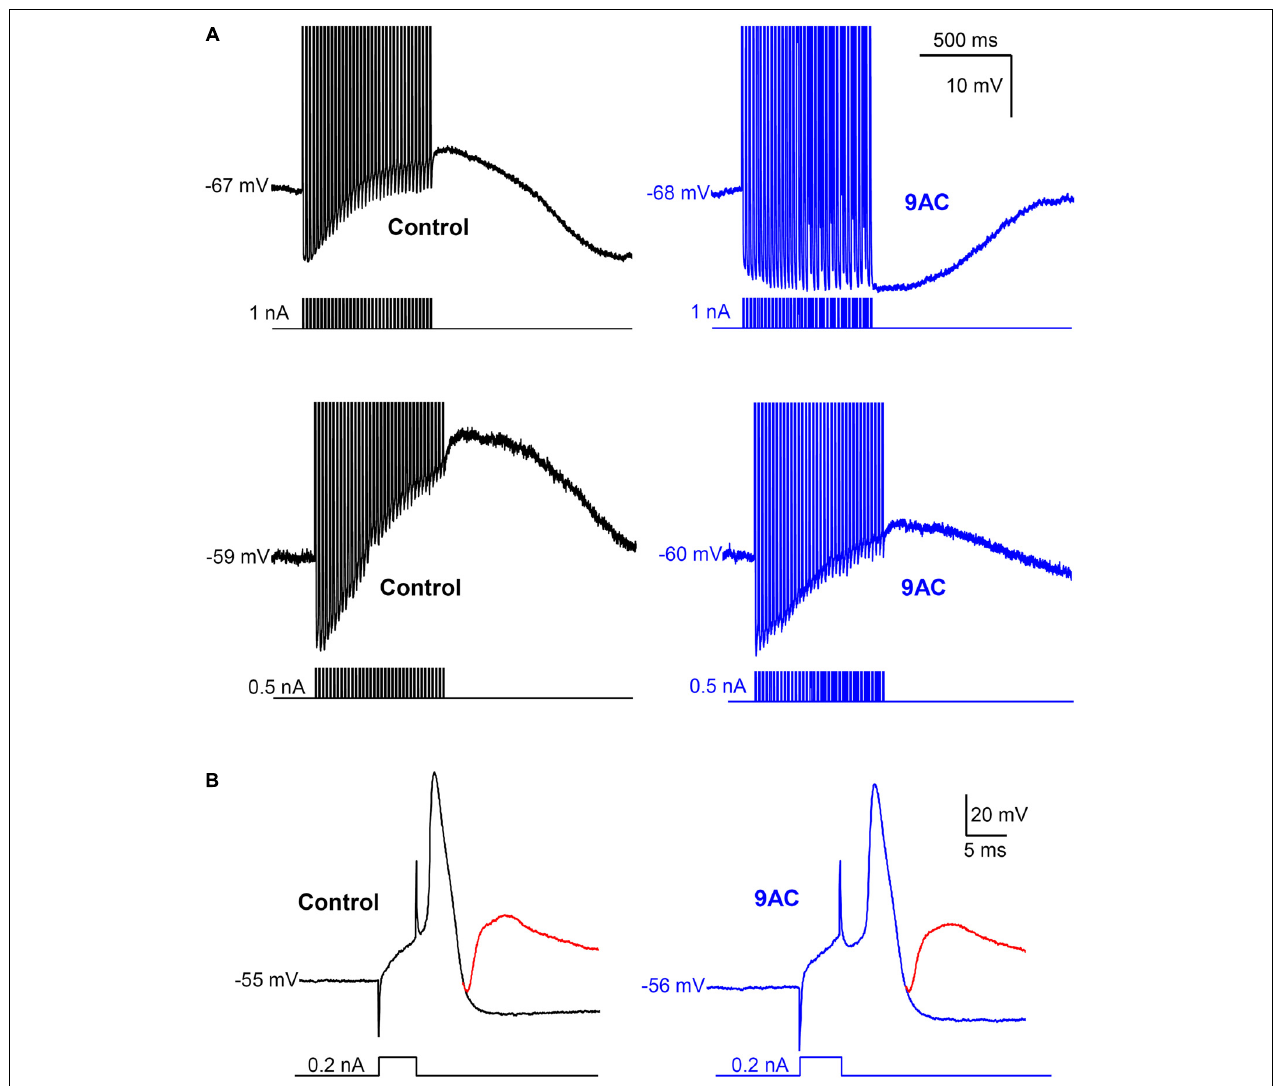
FIGURE 4 | Anthracene-9 (cid:48) -carboxylic acid (9AC) abolishes ADPs without affecting synaptic transmission. (A) Representative recordings of ADPs were evoked after a train of 35 APs in control solution (black traces). ADPs disappeared completely (top panel) or were significantly reduced (low panel) after the addition of 2 mM 9AC (blue traces). Recordings of top panels are from the same cell before and after application of 9AC. The same applies to low panels. APs were evoked with short (5 ms) intracellular current pulses at 35 Hz shown in each recording below the membrane potential. Spikes are truncated at the top. Calibration bars apply to all panels. (B) Representative recording of an excitatory post-synaptic potential (EPSP) elicited with preganglionic stimulus in the refractory period of the AP of one cell in control solution. Addition of the chloride channel blocker 2 mM 9AC does not significantly modify the amplitude of EPSP. Two recordings are overimposed in B , one without stimulation of the preganglionic trunk (black and blue traces for control and 9AC, respectively) and the other with its stimulation and the evoked EPSP (red traces). Calibration bars apply to both panels. APs were evoked with a short (5 ms) intracellular current pulse shown in each recording below the membrane potential. The RMP of the cells is indicated at the beginning of each